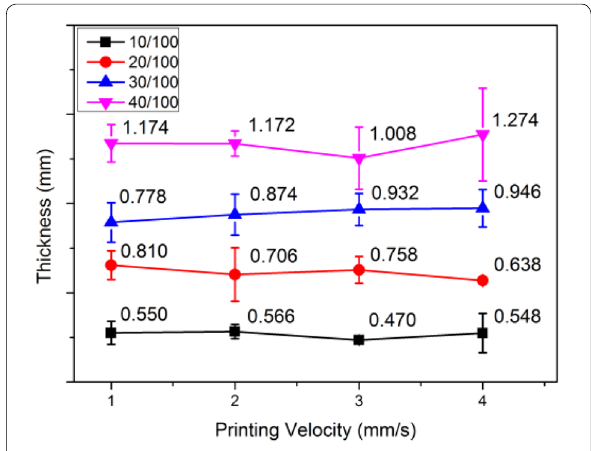
Figure 6 Thickness-printing velocity of specimens at different amounts of wire feeding